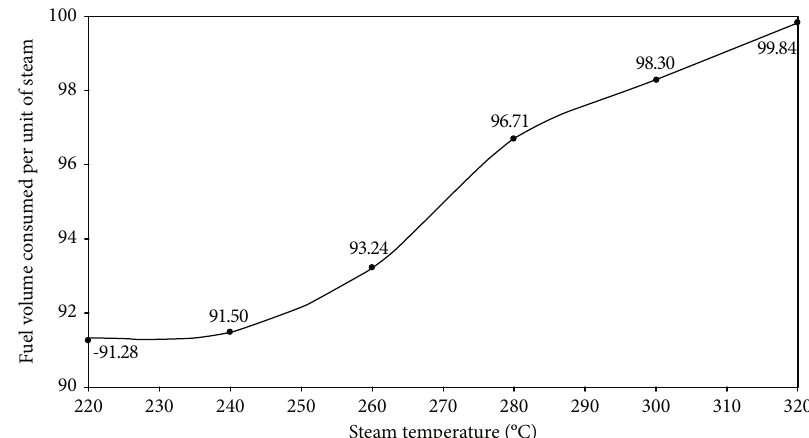
Figure 26: The volume of fuel consumed to produce a unit volume of steam in di ff erent temperatures [40].